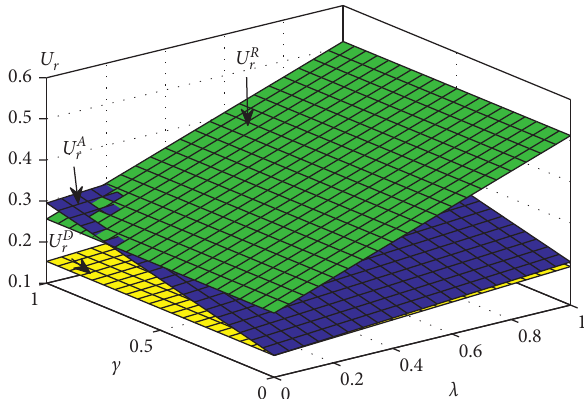
Figure 3: Impact of the retailer’s fairness concerns on the retailer’s utility.